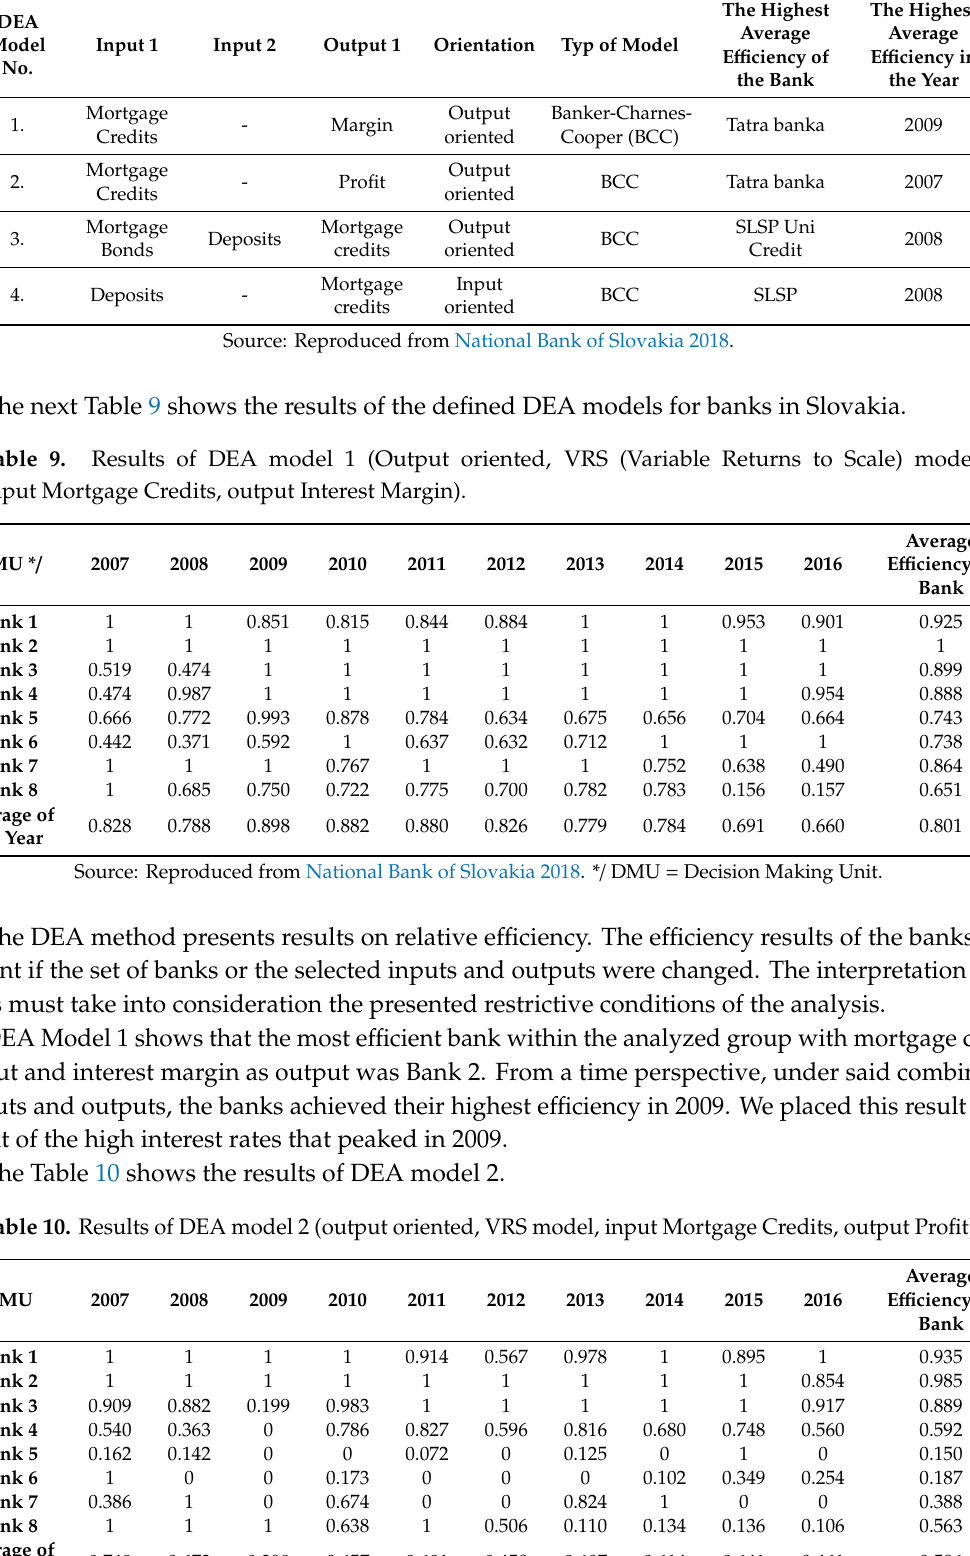
Table 8. Data Envelopment Analysis (DEA) Models of Technical E ffi ciency measurement. DEA Model